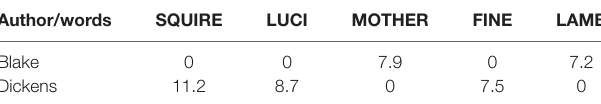
Table 1 | Five unique words with usage rates (1/1,000) in Blake’s and Dickens’ poems of the